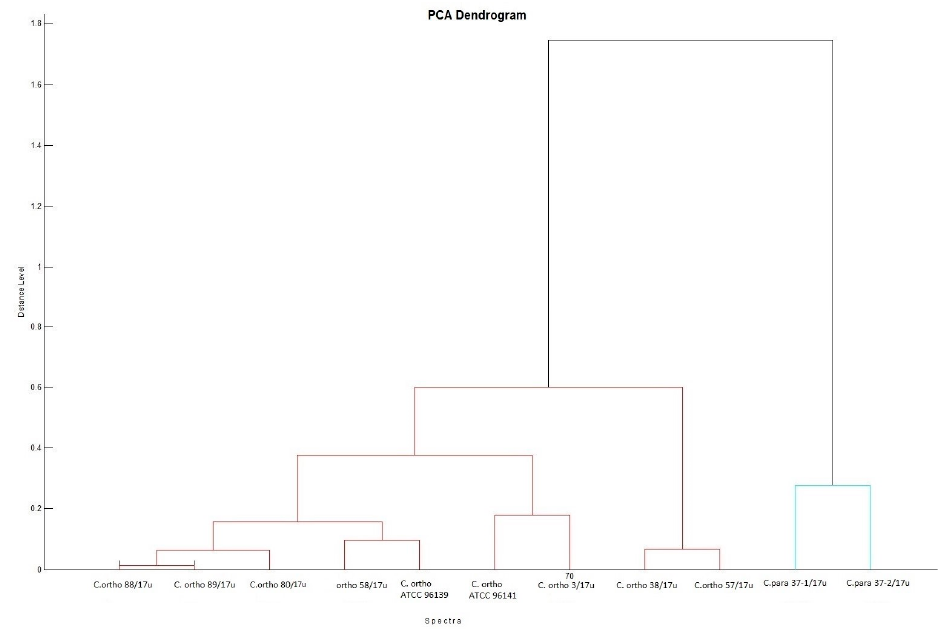
Figure 2. Biotyper PCA (principal component analysis) dendrogram clustering representative MSPs for isolates of C. orthopsilosis and C. parapsilosis with distances displayed in relative units on the y-axis; MSPs for isolates of C. orthopsilosis are clustered with MSPs for reference C. orthopsilosis ATCC 96139 and ATCC 96141. Protein similarity presented on dendrogram by means of a relative distance level between isolates included into dendrogram, normalized to a maximum value of 1000 (cut-off). All tested isolates are presented by their abbreviated species name ( C . ortho and C . para ) and the isolation number. Table 2. Susceptibility of C. orthopsilosis and C. parapsilosis to antifungal drugs detected by